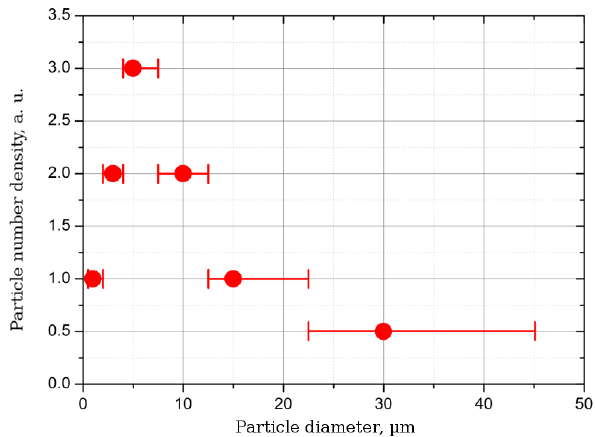
Figure 3. Sketch of the particle size distribution represented by COSMO-ART for the Eyjafjallajökull dispersion simulation (red dots). The red lines with bars indicate the averaging margins that were defined for the calculation of effective optical cross